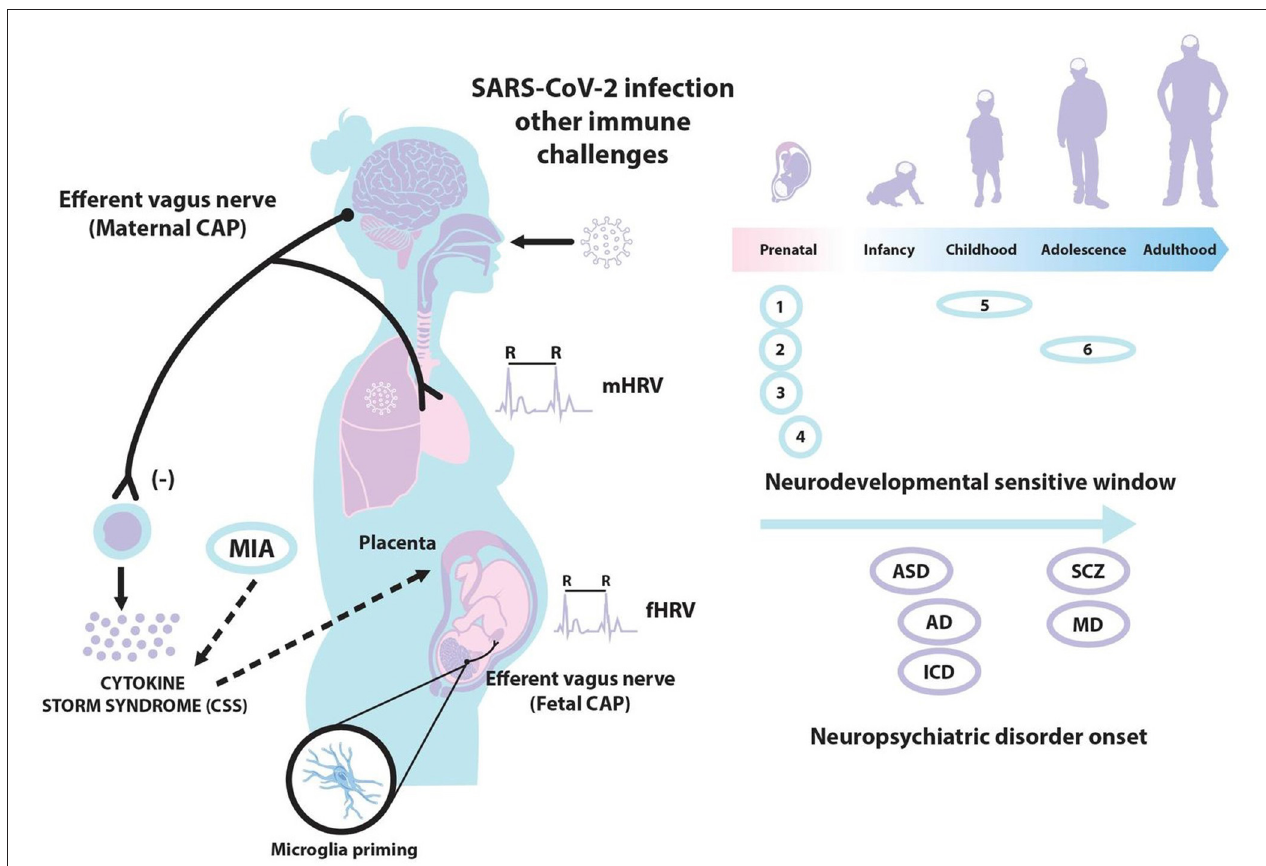
FIGURE 1 | A gestational infection triggered by SARS-CoV-2 may produce a maternal immune activation (MIA) and cytokine storm syndrome (CSS). The activation of the maternal and/or fetal cholinergic anti-inflammatory pathway (CAP) via the efferent vagus nerve and transplacental interactions could downregulate such CSS. The analysis of maternal and fetal heart rate variability (mHRV and fHRV) might be considered for assessing maternal and fetal CAP activation. Also, a gestational infection by SARS-CoV-2 may produce fetal neuroinflammation and microglial activation, increasing the risks of several neurodevelopmental disorders in the offspring and even an altered long-term cognitive function in adulthood: (1) neuronal migration; (2) axonal and dendritic growth; (3) programmed cell death; (4) synaptogenesis; (5) myelination; and (6) process modeling/synaptic refinement. ASD, autism spectrum disorder; SCZ, schizophrenia; AD, anxiety disorders; MD, mood disorders; ICD, impulse-control